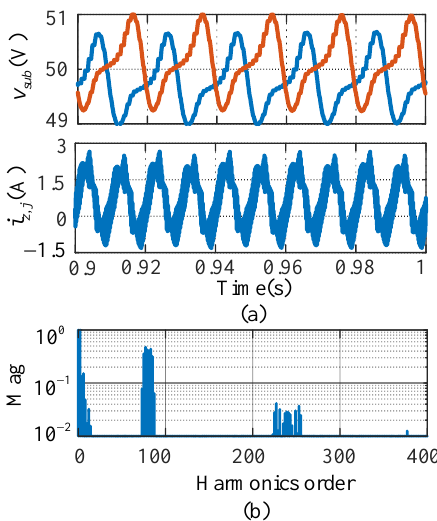
Figure 15. Simulation results of PSC2. ( a ) Capacitor voltage of SMs and circulating current. ( b ) FFT analysis of circulating current.